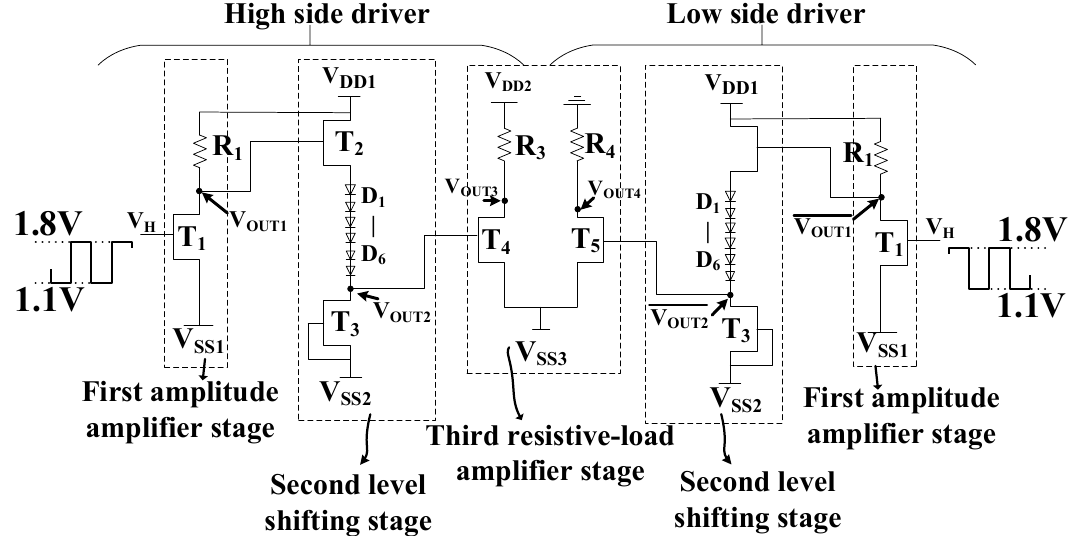
Figure 2. Schematic of the driver including a high side driver (V OUT3 to drive T HS ) and low side driver (V OUT4 to drive T LS ).